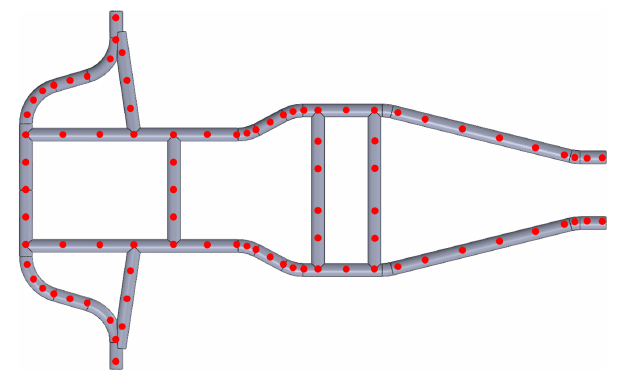
Figure 24. Schematic diagram of the 86 measuring points in the experimental modal